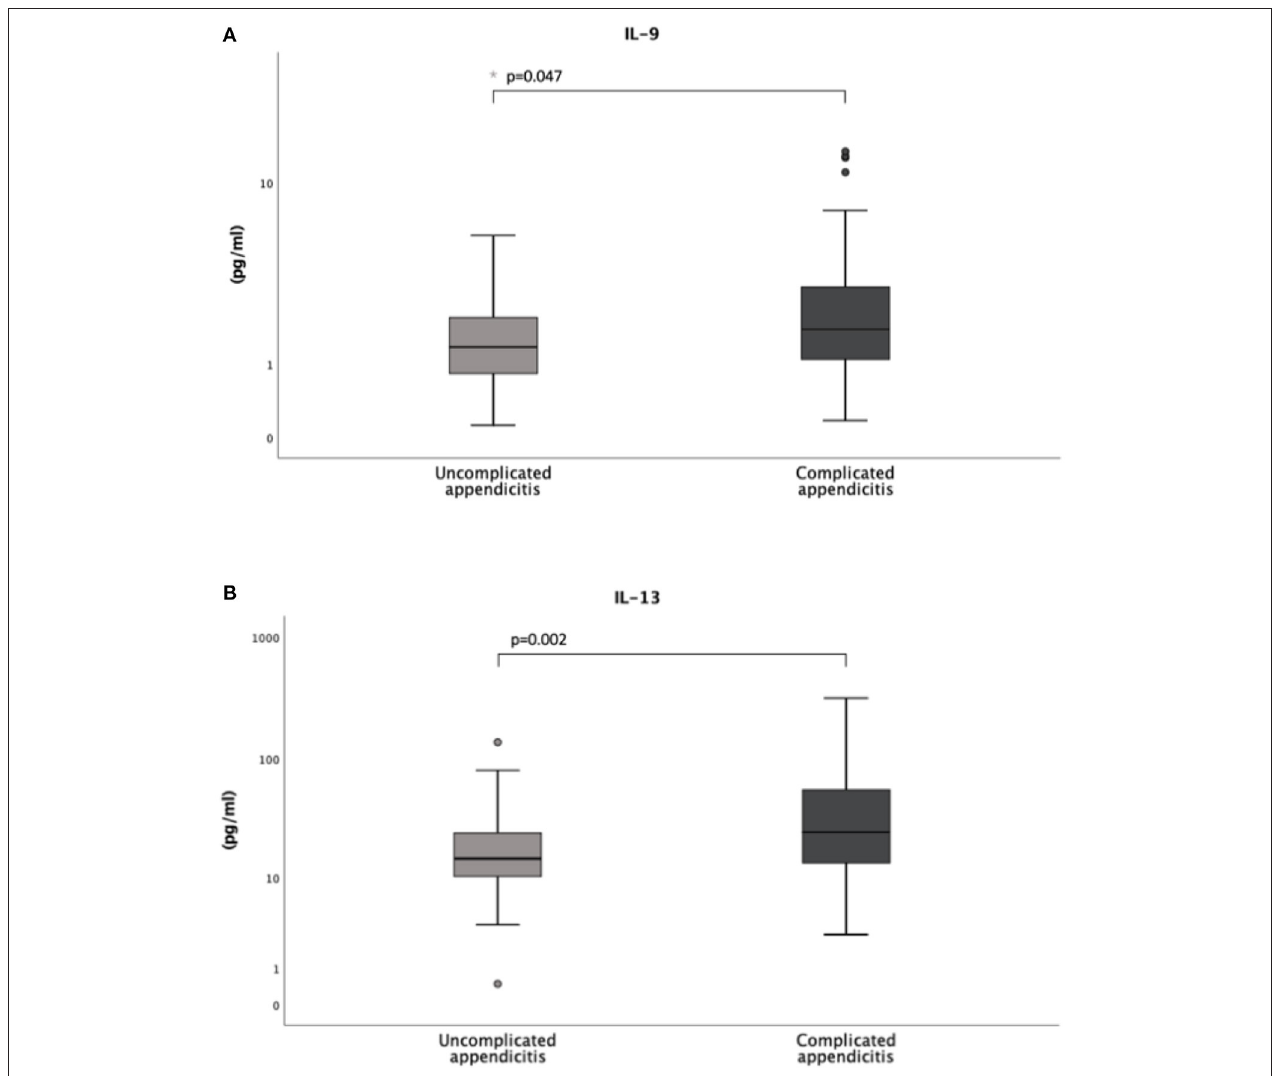
FIGURE 2 | Levels of interleukin IL-9 (A) and IL-13 (B) in a cohort of 138 children with uncomplicated and complicated appendicitis. Both the circles and the asterisk (*) in the box plots represent